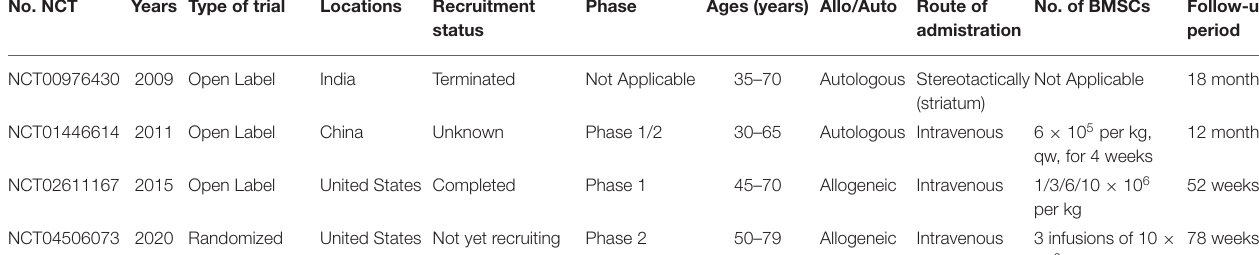
No. of BMSCs Follow-up admistration